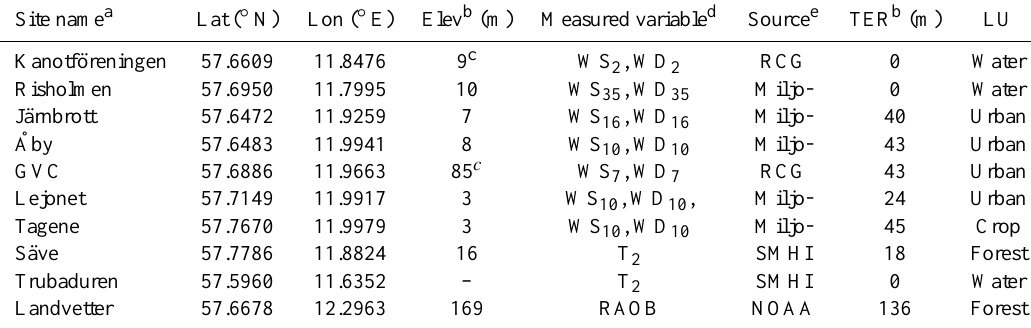
Table 2. Name, location and other information for observational sites used in this study (Lat: latitude, Lon: longitude, Elev: elevation), as well as model terrain (TER) height and dominant land use (LU) represented in 2-km resolution (D4) closest to observational